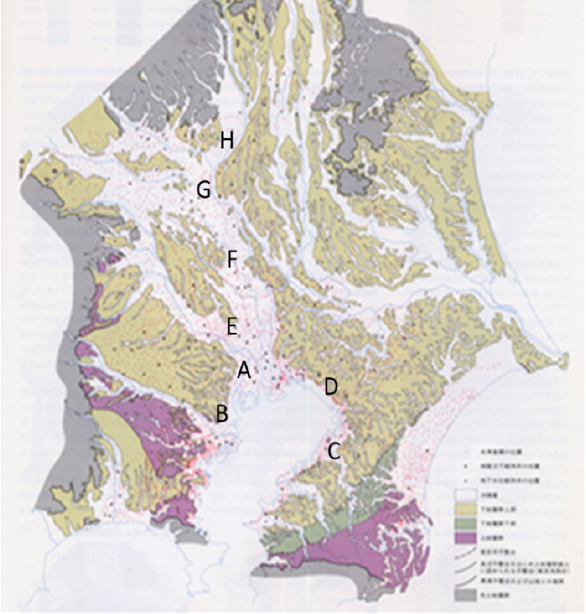
Figure 2. Kanto groundwater basin and the distribution of moni- toring wells and benchmarks. Large dots: monitoring wells, small dots: benchmarks. A–E: monitoring wells which data were used in Fig.